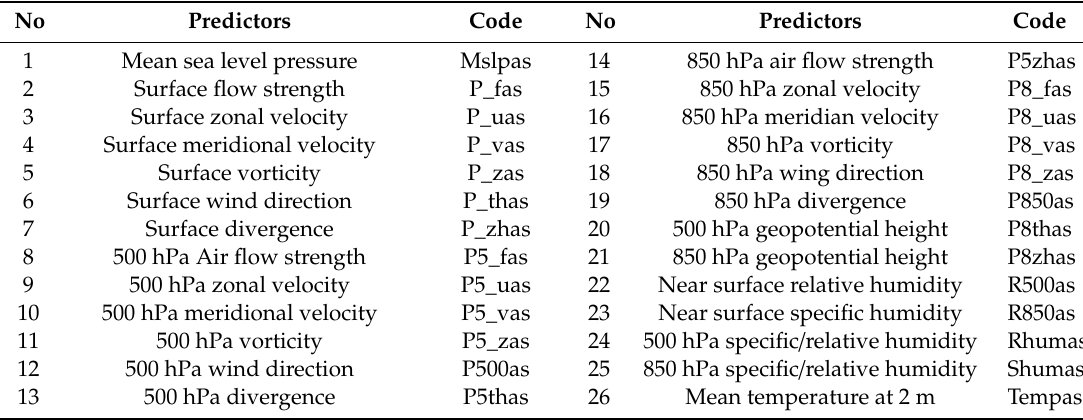
Table 1. List of 26 NCEP (National Centers for Environmental Prediction) predictors used in this